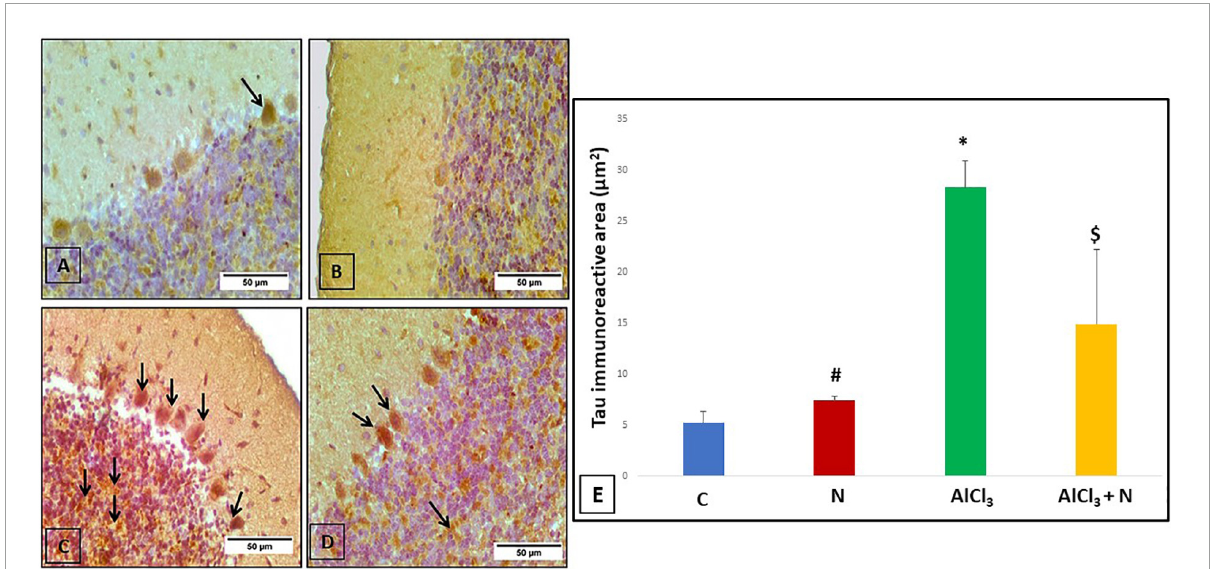
FIGURE7 Immunohistochemical detection of cerebellar tau protein: (A) The control rat showed weak positive tau immunoreaction in a Purkinje cell (arrow). (B) The rat showed negative tau immunoreaction. (C) AlCl 3 group showed a strong positive tau immunoreaction in most Purkinje and granule cells (arrows). (D) The rat treated with combined AlCl 3 and N showed weak positive tau immunoreaction in some Purkinje and granule cells (arrows) (Tau × 400). (E) Area% of tau-positive immune reaction in cerebellar sections of all studied groups. n = 6 in each group. Data were prescribed as mean ± SD . The intergroup variation was conducted by Games-Howell post-hoc test. ∗ p < 0.001 compared with C group. # p < 0.001 compared with AlCl 3 . $ p < 0.001 compared with AlCl 3 .